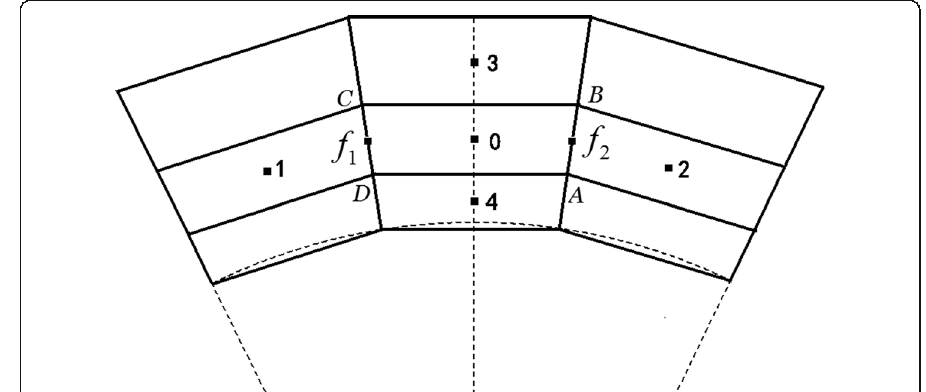
Fig. 7 Quadrilateral grids on a curved